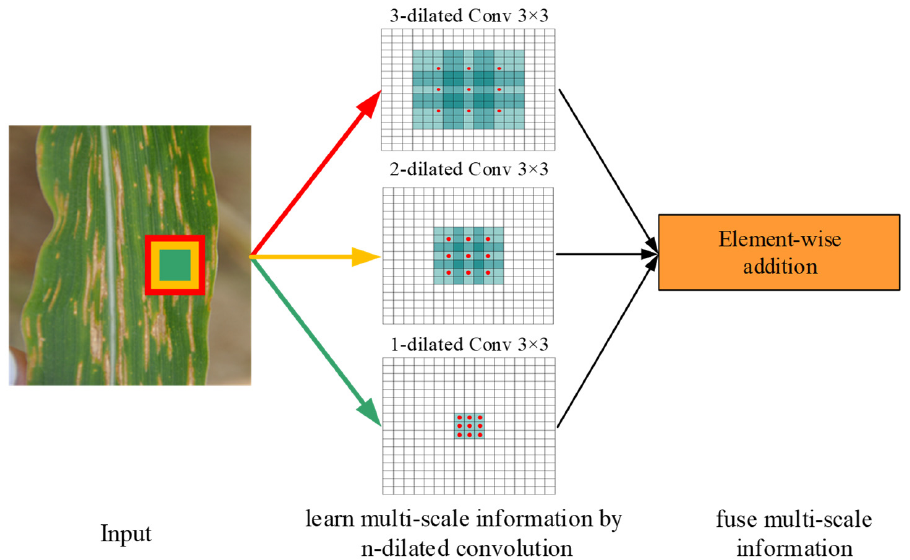
Figure 5. Multi-scale dilatation convolution; how to learn multi-scale feature information.